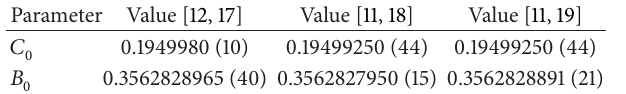
Table 1: Ground state constants (cm − 1 ) of 14 NF